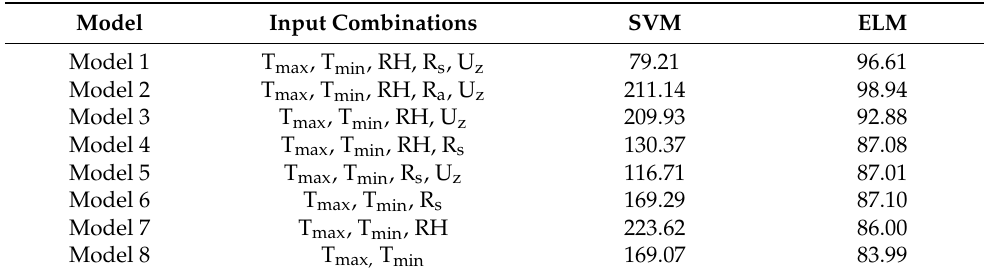
Table 13. Average run time (in seconds) of SVM and ELM under different input combinations in the estimation of daily